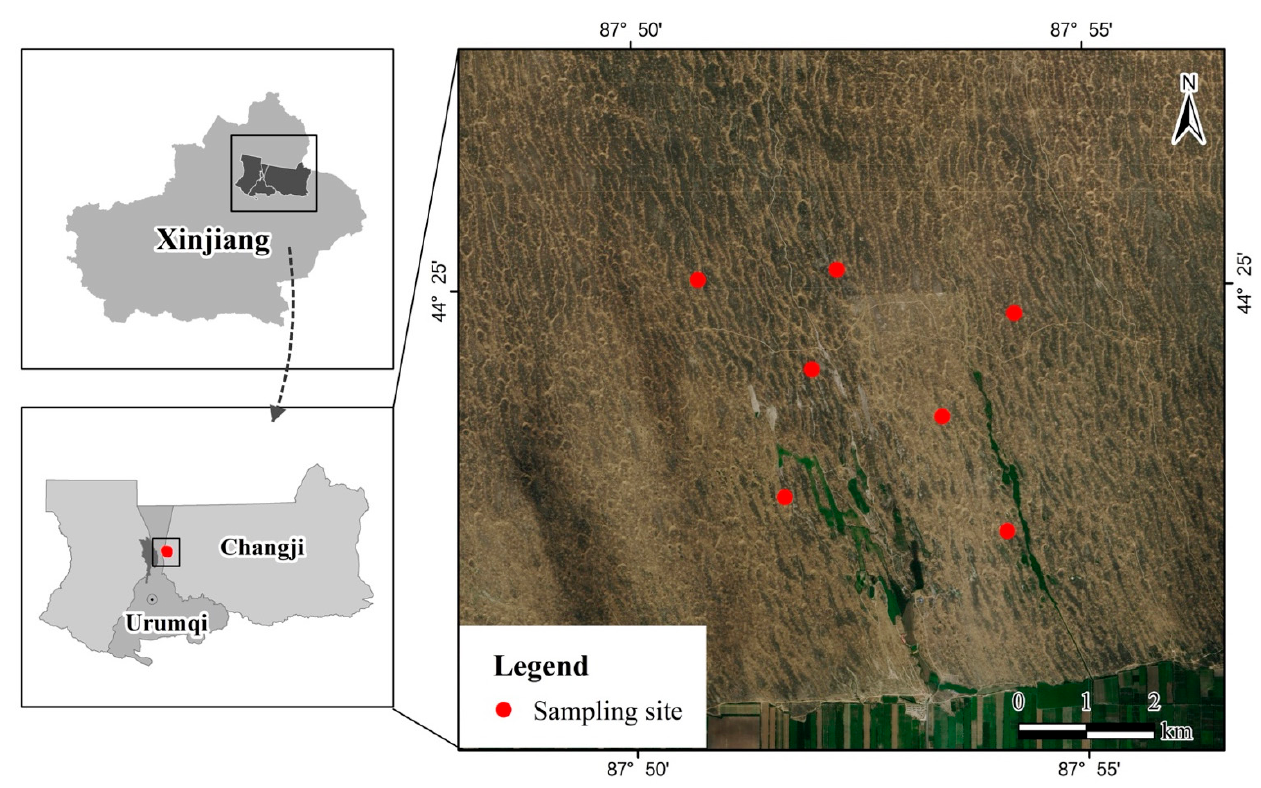
Figure 1. Locations of rodent sampling in the Wutonggou Desert, Fukang city, Xinjiang China.